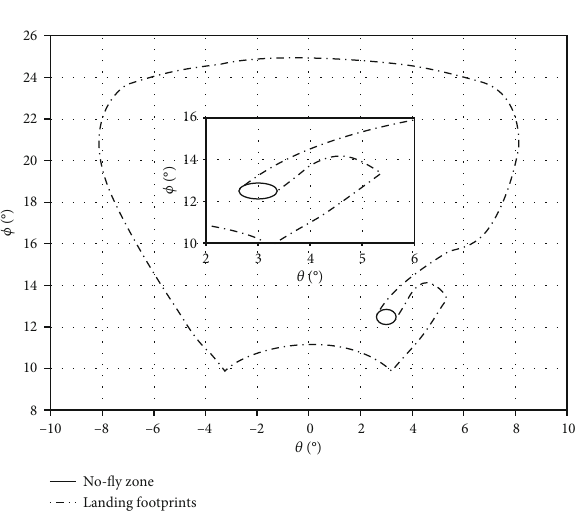
Figure 32: Landing footprints for Case